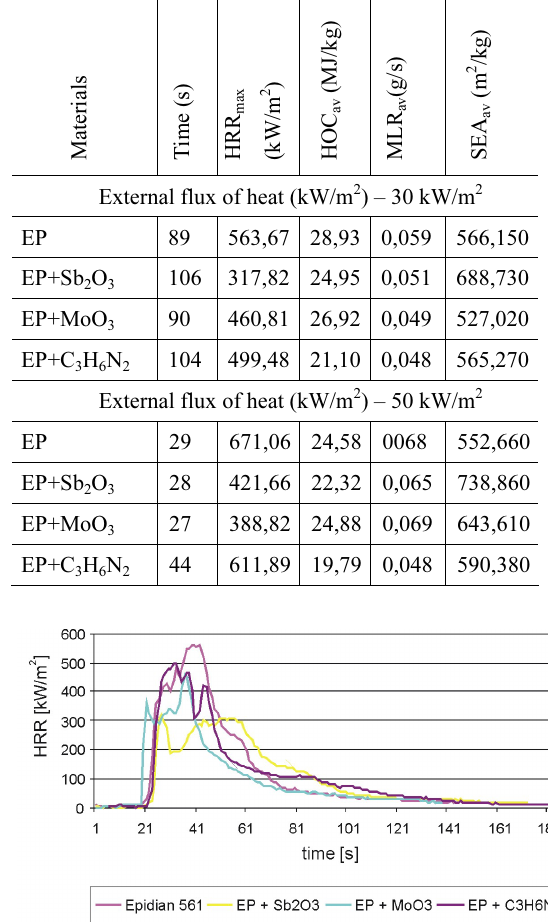
Fig. 1. The heat release rate curves of unmodified (Epidian 561) and modified epoxy material at external flux of heat 30 kW/m 2